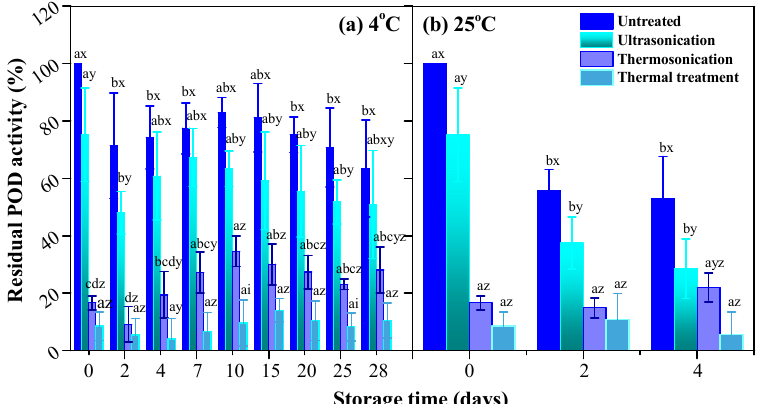
Figure 7. The residual activity of POD in red pitaya juices during storage at 4 °C ( a ) and 25 °C ( b ), as subjected to thermosonication (475 W, 56 °C, 20 min), ultrasonication (475 W, 10 °C, 20 min), and thermal (83 ◦ C, 1.5 min) treatments. a, b, c, d means significant difference with respect to storage time ( p < 0.05); x, y, z, i means significant difference with respect to various treatments ( p <